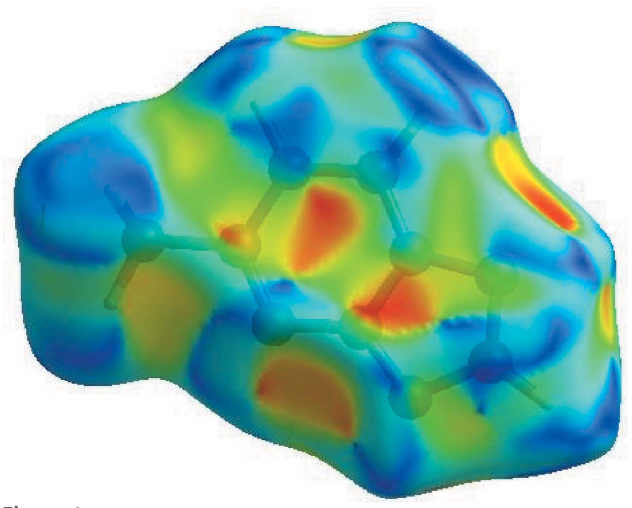
Figure 6 Hirshfeld surface of the title compound plotted over shape-index.